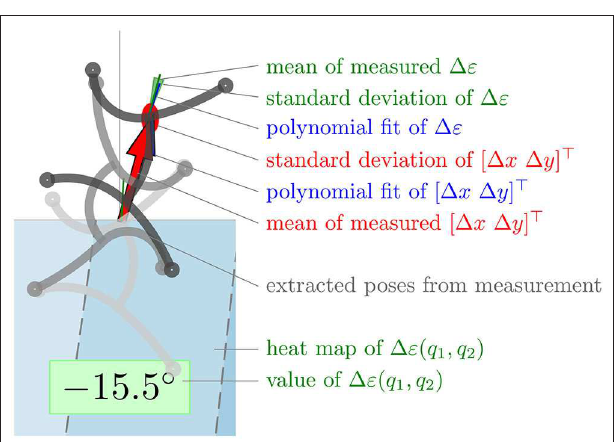
FIGURE 8 | Detailed view of resulting experimental gait according to the gait law for ( q 1 , q 2 ) = (90 ◦